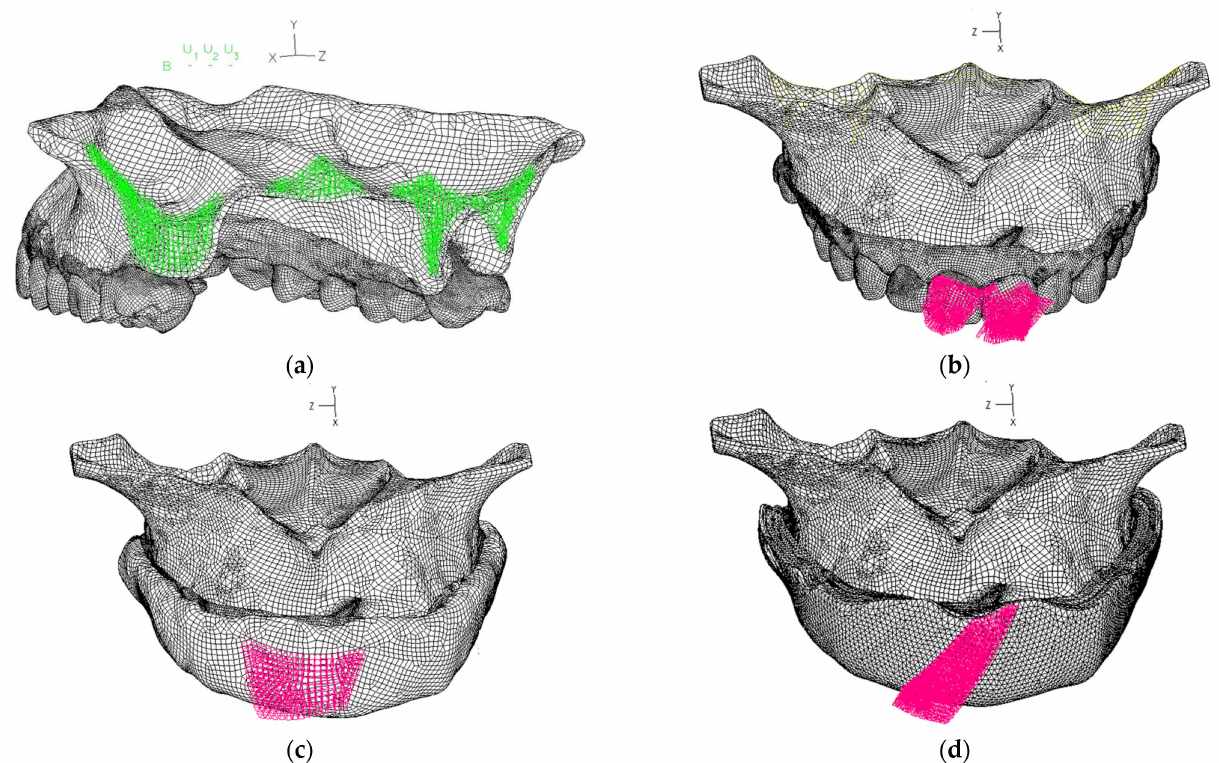
Figure 3. Representation of numerical conditions used within all models: ( a ) boundary conditions applied on the posterior region of the maxilla; ( b ) pressure applied in the two surfaces of the of central incisors (NMP); ( c ) pressure applied in the surfaces of the CMG model; ( d ) pressure applied in the surfaces of the FMG and HMG